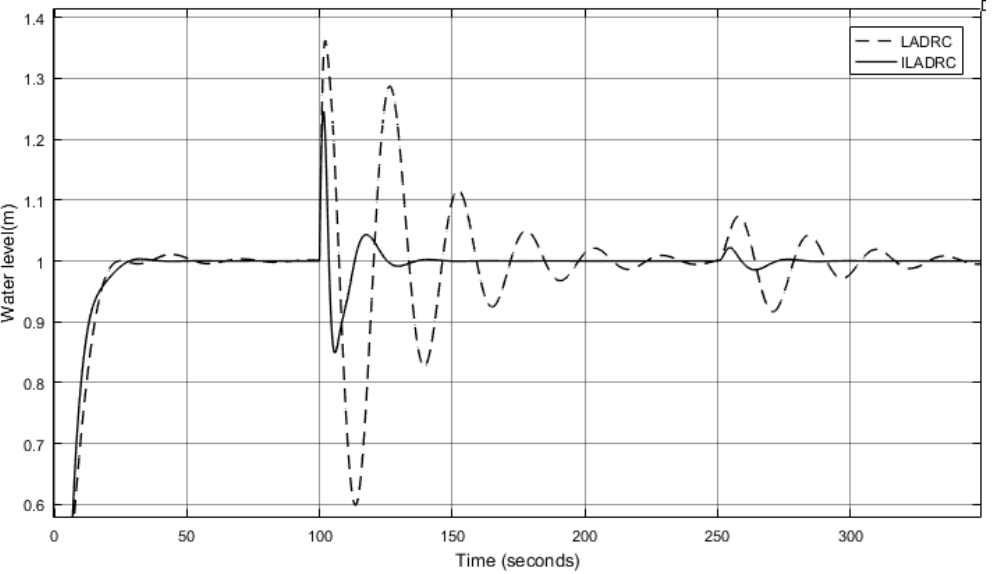
Figure 8. Comparison of LADRC and ILADRC with the model parameter G W decreasing.